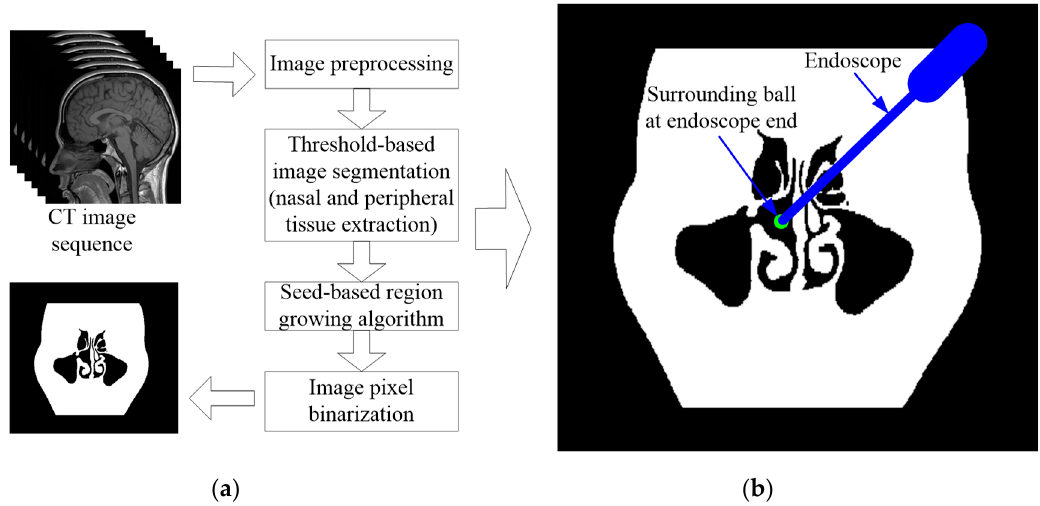
Figure 4. Schematic diagram of the FRVF based on the anatomical structure of the nasal cavity. ( a ) The point cloud model acquisition process, ( b ) the FRVF based on the anatomical structure of the nasal cavity.